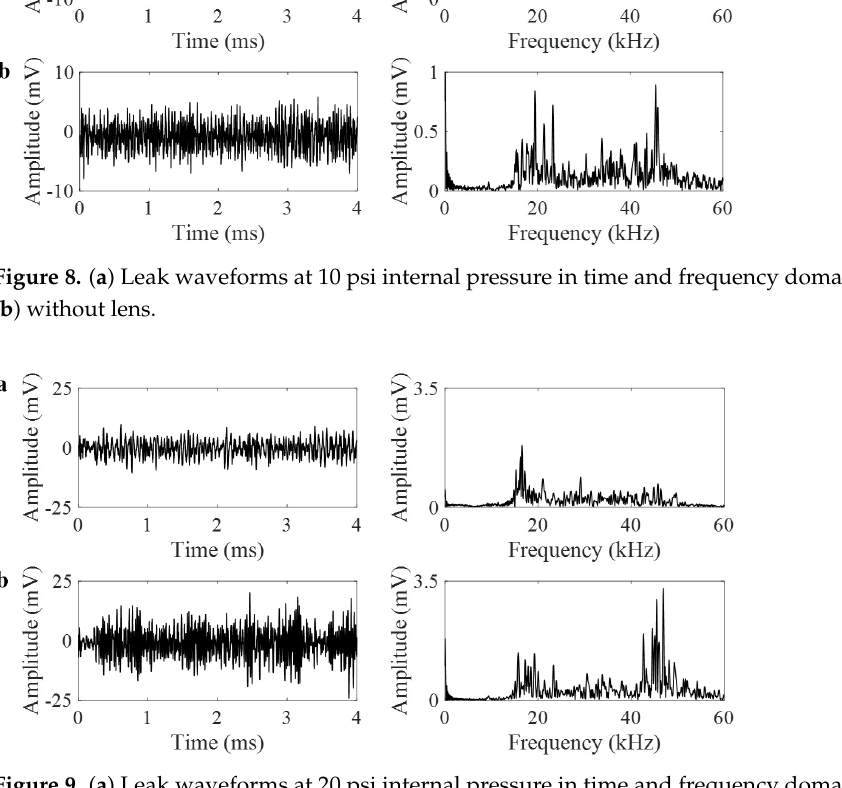
Figure 9. ( a ) Leak waveforms at 20 psi internal pressure in time and frequency domains with lens, ( b ) without lens.